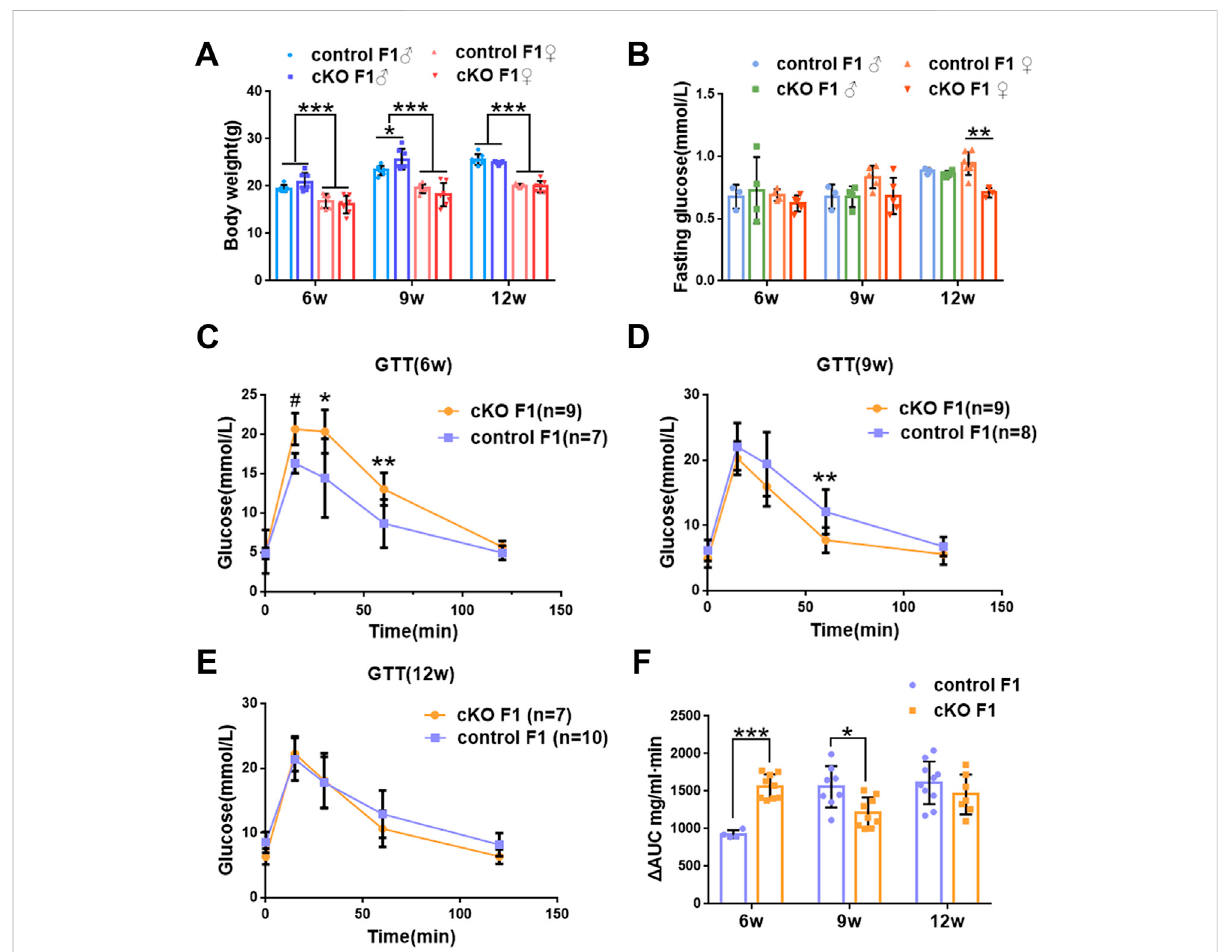
FIGURE 2 Glucose homeostasis was impaired in the F1 generation of endometrial DNMT3B conditional knockout female mice (A) The body weight of the F1 generation was recorded continuously at 6-weeks, 9-weeks and 12-weeks of age (n = 7). (B) Fasting blood glucose level of the F1 generation at 6- weeks,9-weeksand12-weeksofage(n=7 – 9). (C – E) GlucosetoleranceintheF1generationat6-weeks,9-weeksand12-weeksof agewasmeasured continuously(n= 7 – 10). (F) The areaunder thecurve ofglucose toleranceincontrol and cKO F1mice at6-weeks,9-weeks and 12-weeksofage. Results are presented as mean ± SEM. * p < 0.05, ** p < 0.01, *** and # p < 0.001. GTT, glucose tolerance test. AUC, the area under the